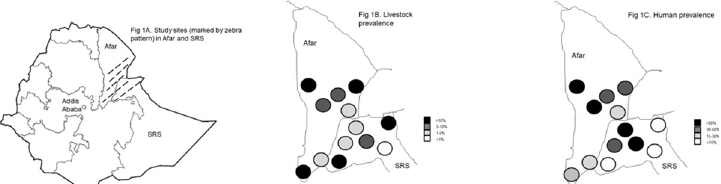
Fig 1. Map of Ethiopia showing the study sites (1A), the brucellosis prevalence in livestock (1B) and the prevalence in humans (1C). Map baselayer for all 3 maps is from: https://commons.wikimedia.org/wiki/File:Ethiopia_regions_blank.